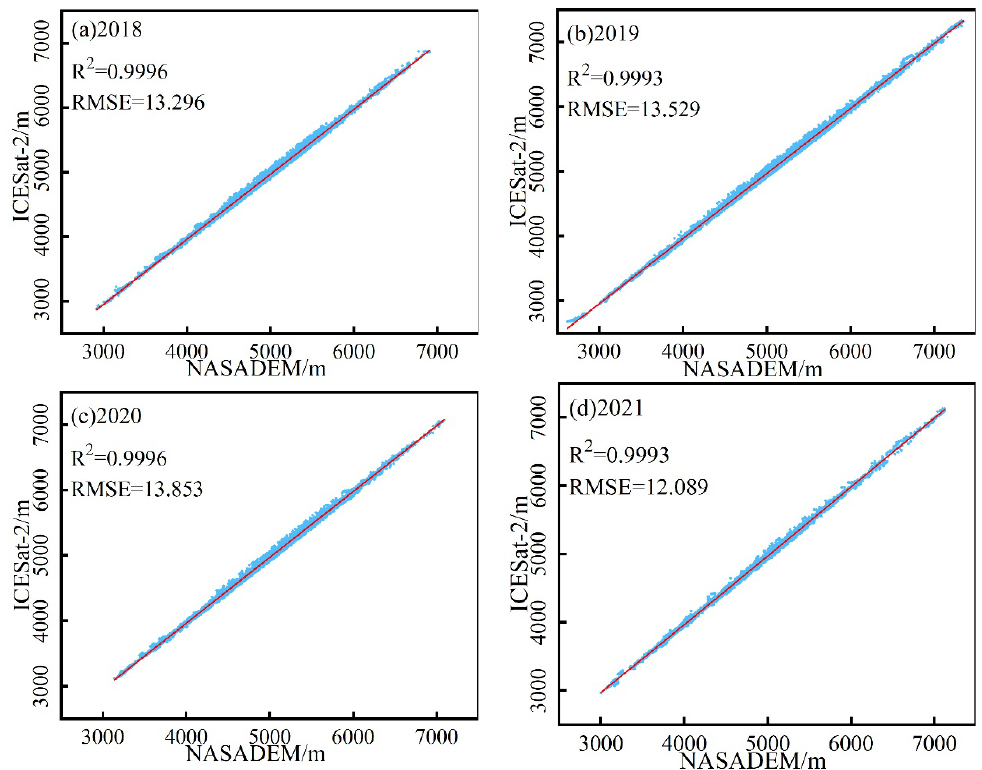
Figure 6. Liner fit of ICESat-2 and NASA DEM elevation differences from 2018 to 2021 for yearly